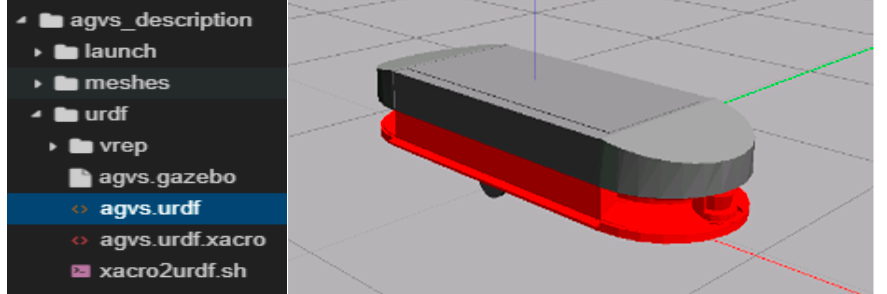
Figure 18. 3D model of an AGV in Gazebo.